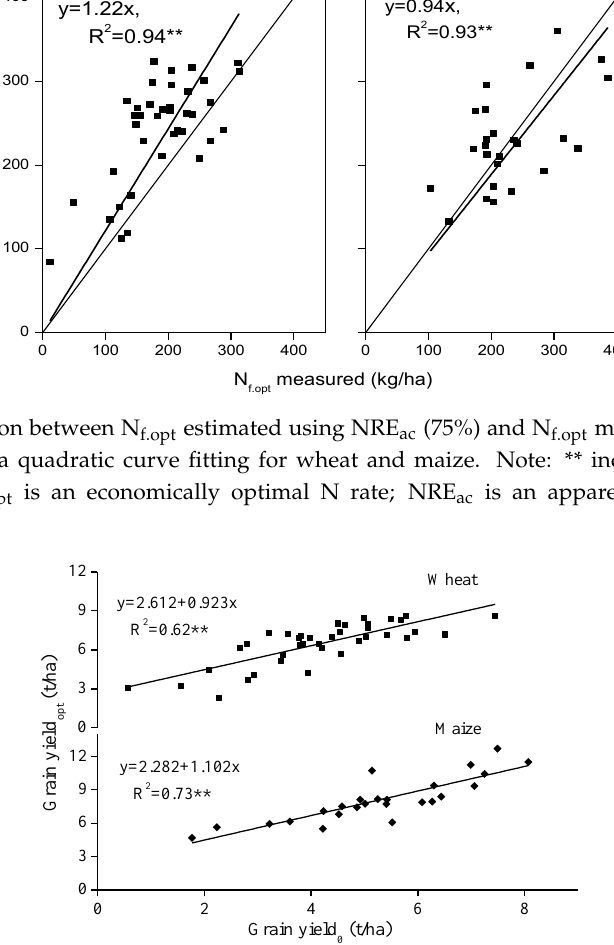
Figure 3. Relationships between grain yield opt and yield 0 for wheat and maize based on 3414 experiments. Note: ** indicates significance at 0.01 levels; grain yield opt is a grain yield at N f.opt ; grain yield 0 is a grain yield without N input.